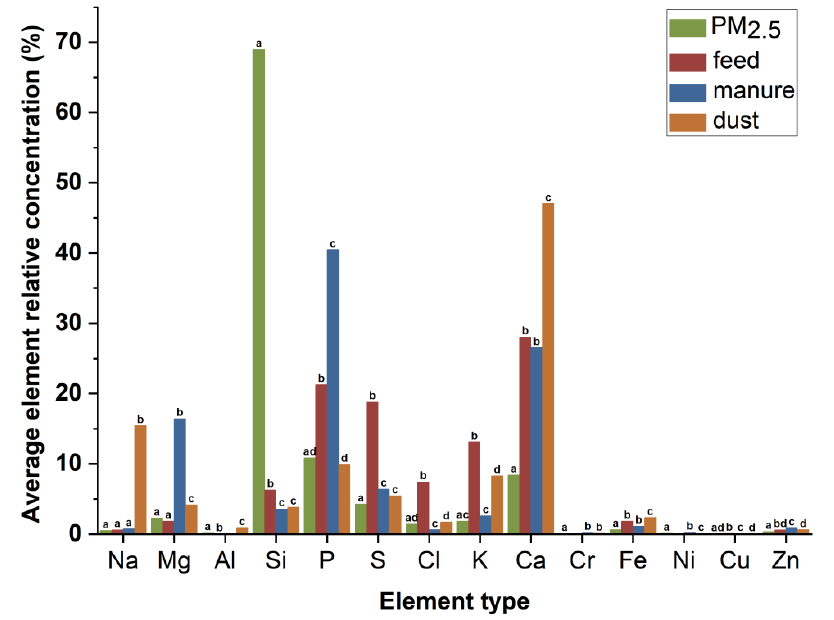
Figure 3. Average element relative concentration (%) for particles from different sources. n = 6 for PM 2.5 and n = 3 for others. Averages within an element lacking common superscript letters are significantly different ( p < 0.05). Table 2. Summary of quantitative determination results of heavy metals.